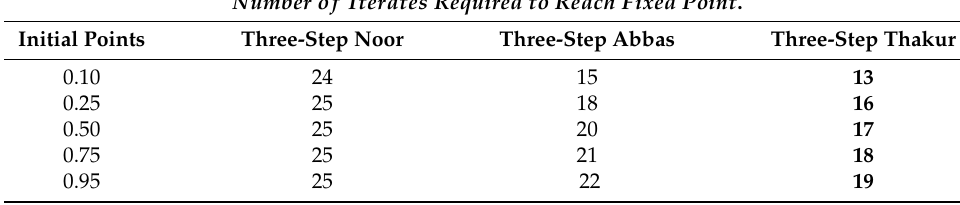
Table 4. When a k = 1 − ( 1 Number of Iterates Required to Reach Fixed Point